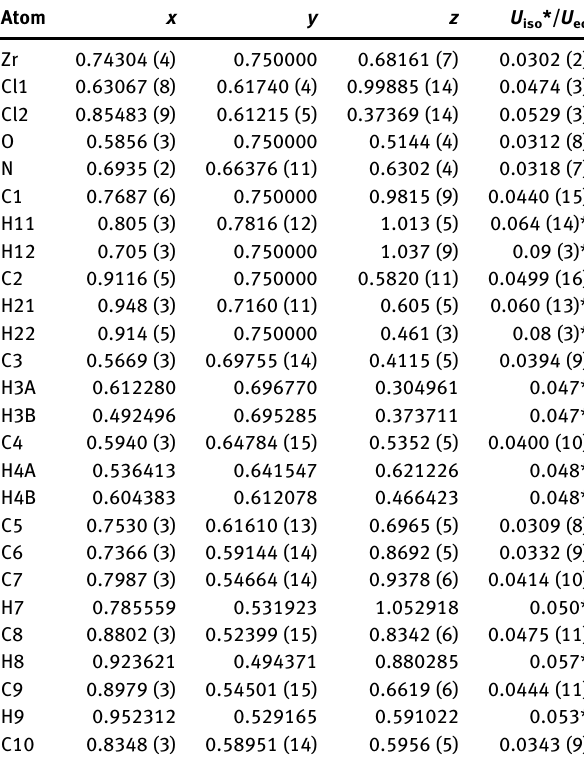
Table  : Fractional atomic coordinates and isotropic or equivalent isotropic displacement parameters (Å 